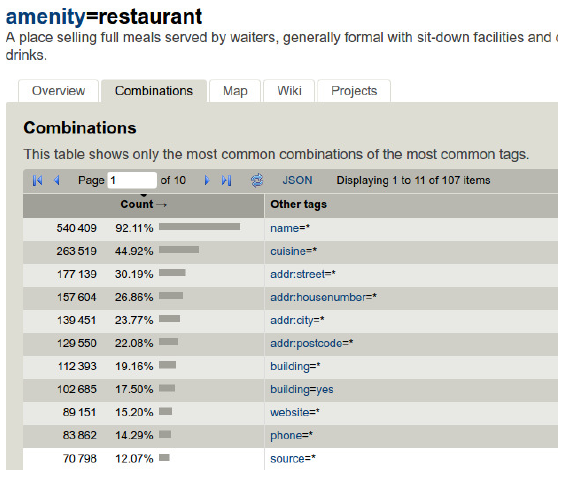
Figure 2. In this screenshot from the TagInfo page for amenity=restaurant , a number of co-occurring keys that are combined with this tag are